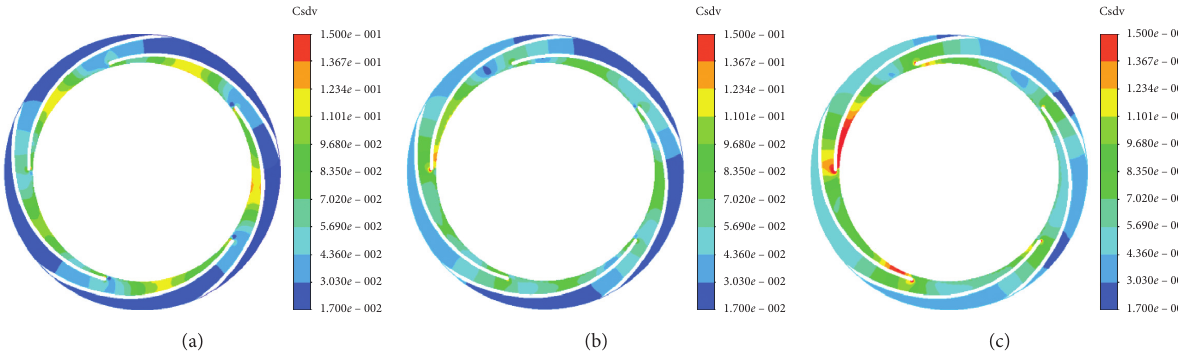
Figure 10: Intensity distribution of cross-sectional pressure fluctuation in the guide vane. (a) 0.8 Q / Q